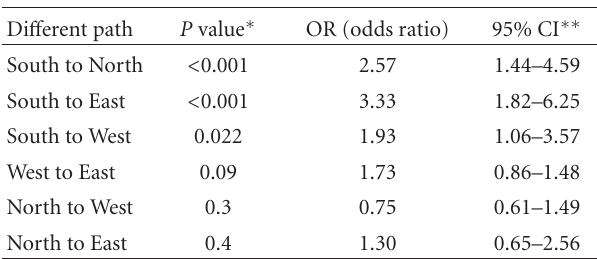
Table 3: Comparison between risk estimation of AMS incidence in di ff erent paths.